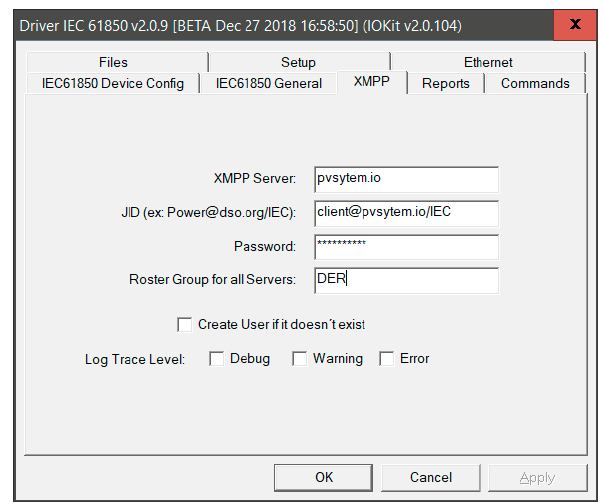
Figure 17. IEC 61850-8-2/XMPP client driver settings.